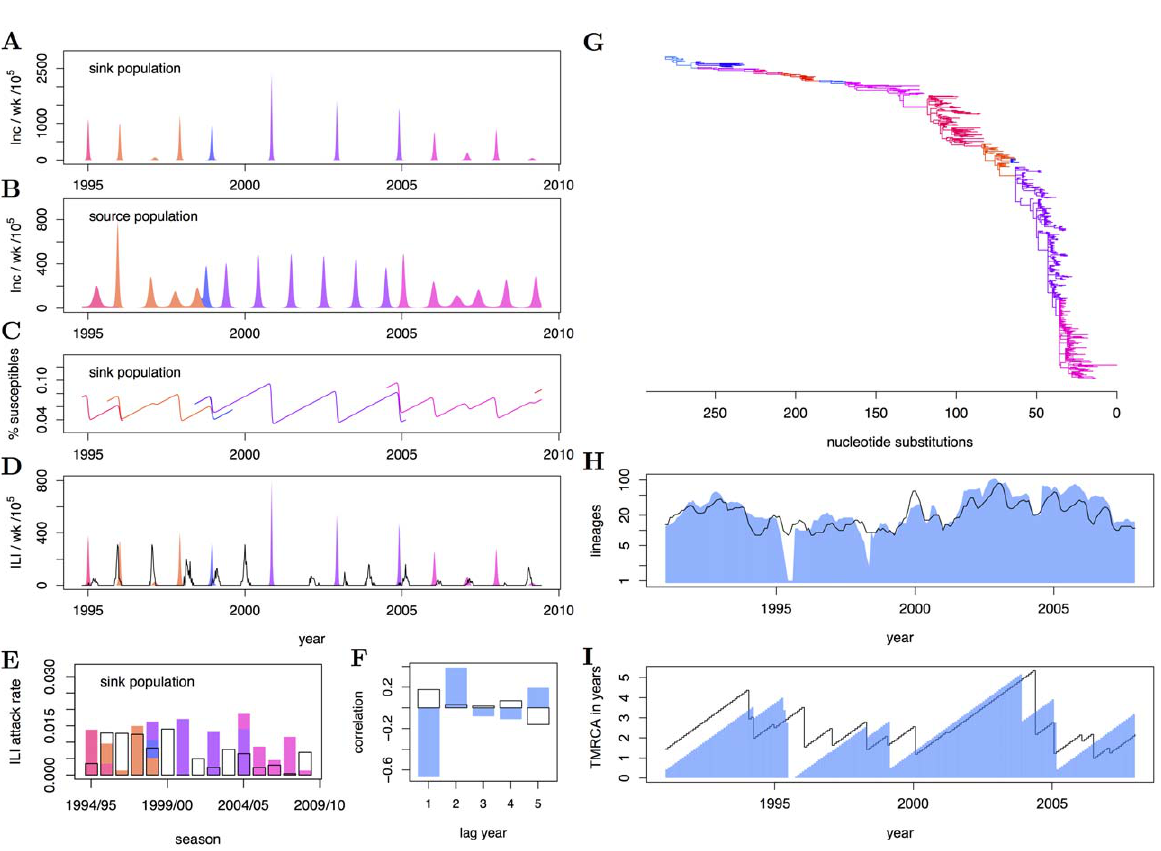
Figure 6. Phylodynamics arising under the fitted, spatial epochal evolution model. (A–I) Subplots are as in Figure 4. Typically, simulations under the fitted model display large infection waves and strong genetic bottlenecks at antigenic cluster invasions that are followed by refractory dynamics (A,B,H). These intrinsic dynamics result in irregular variation in case report attack rates that is well in line with H3N2 time series of several countries (E,F). Model parameters are R 0 ~ 24 , 1 = w ~ 0 : 9 , 1 = n ~ 1 : 8 , 1 = c ~ 340 , s i { 1, i ~ 0 : 76 , r ~ 0 : 7 , N s ~ 2 : 7 | 10 8 , 1 = m s ~ 50 , Q ; ~ 0 : 46 , Q s ~ 0 : 012 , m ; ~ 10 | 10 6 , m s ~ 0 : 02 , f ~ 4 : 54 , s ~ 2 : 5 | 10 { 3 , k ~ 2 , l ~ 0 : 78 , and the intrinsic dynamics are generally less pronounced when Q s is higher; see Text S1.